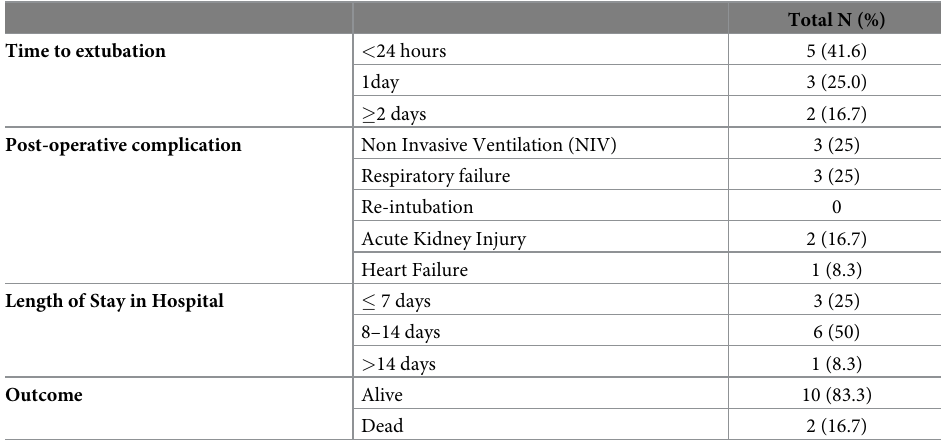
Table 3. Post-operative